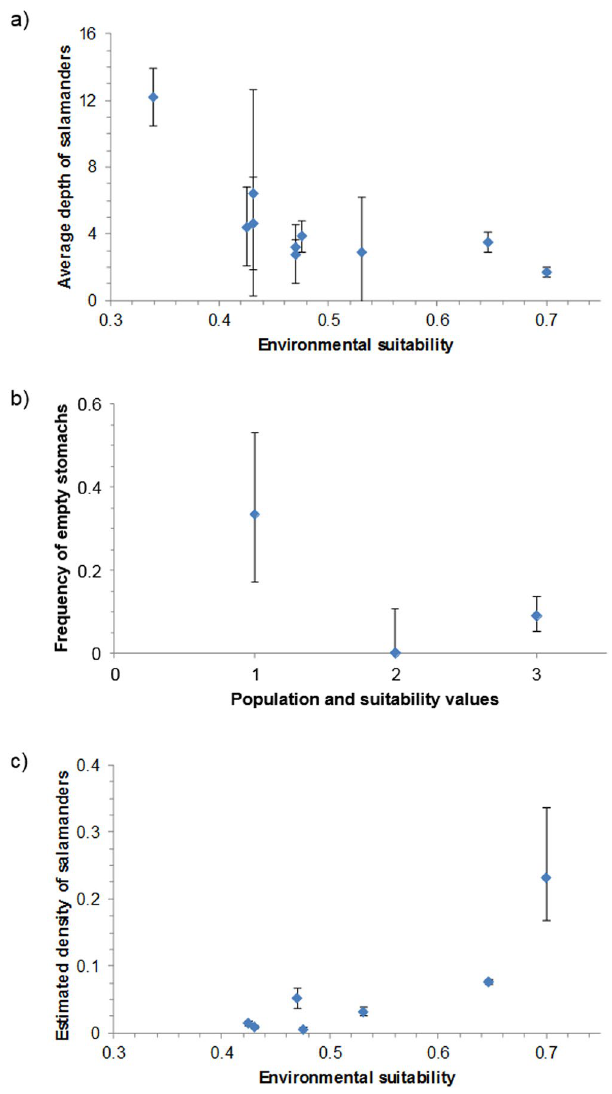
Figure 3. Relationship between features of salamander populations and environmental suitability. ( a ) Activity pattern (distance from cave entrance; log-transformed); ( b ) Feeding performance (frequency of empty stomachs); ( c ) Estimated density (individuals/m 2 ). Bars represent standard